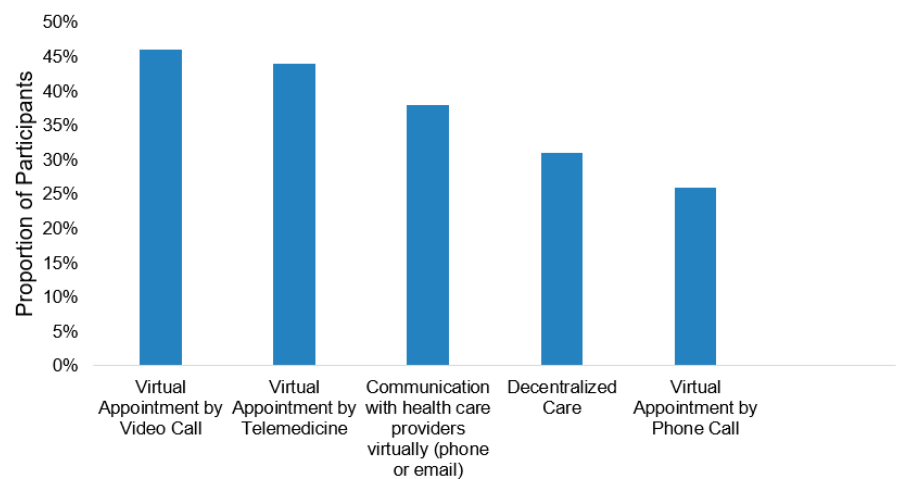
Figure 2. Changes in cancer care delivery associated with a positive impact ( n = 767).